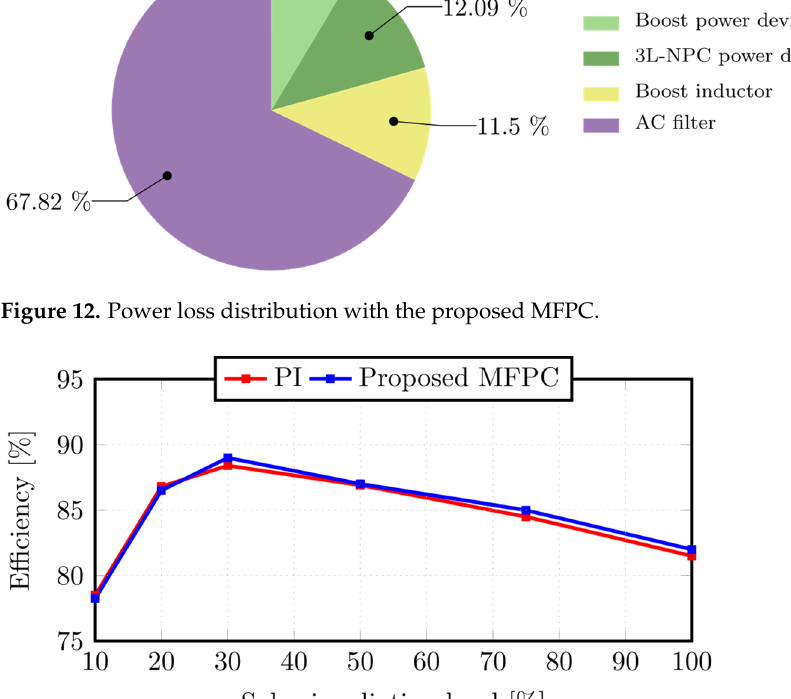
Figure 13. E ffi ciency of the system at di ff erent irradiation levels with the proposed MFPC. Figure 13. Efficiency of the system at different irradiation levels with the proposed MFPC.